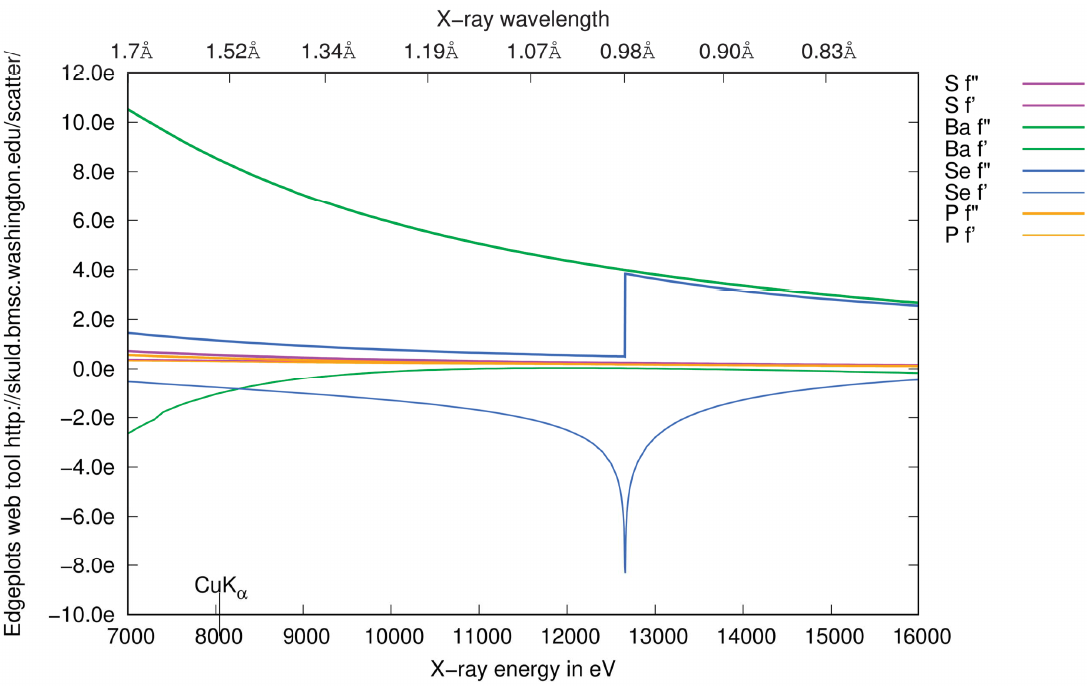
Figure 7. Plot for f (cid:48) and f (cid:48)(cid:48) for some of the more commonly used anomalously scattering atoms.